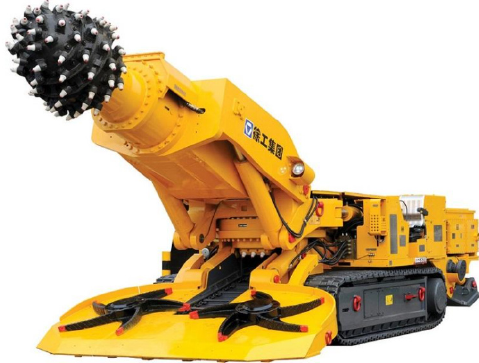
Figure 2. EBZ135A integrated mechanized roadheader.